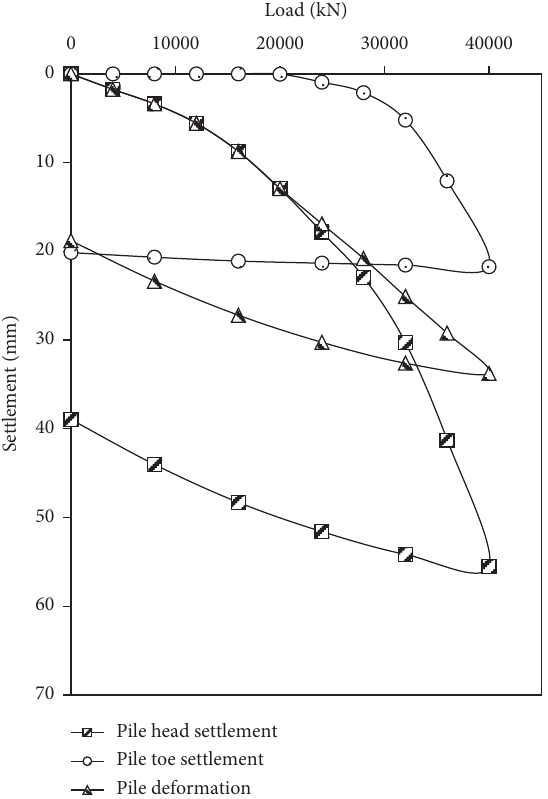
Figure 9: Load-settlement curves of P66.